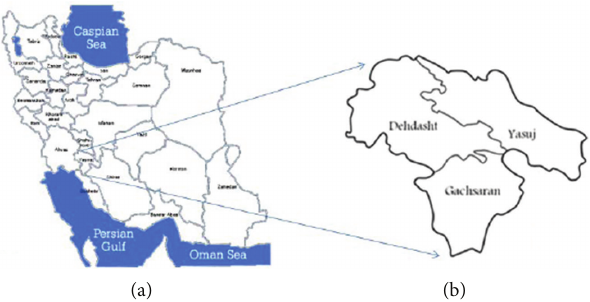
Figure 1: Map of Iran (a) and the Kohgiluyeh and Boyer-Ahmad province